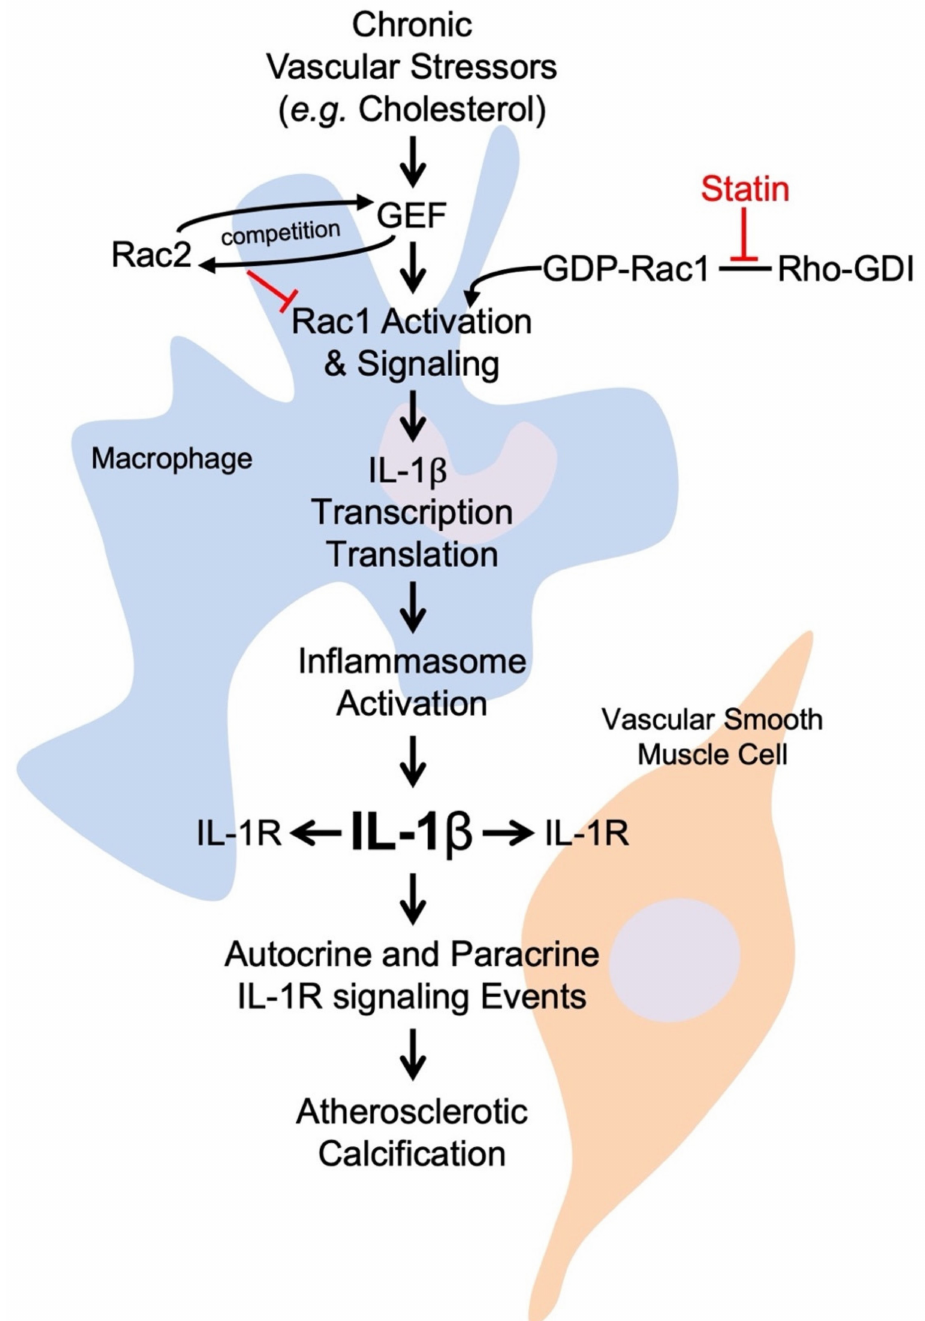
Figure 5. Working model of how Racs mediate IL-1 β expression and the consequent atherosclerotic calcification. Vascular stressors activate innate inflammatory pathways in macrophages, leading to Rac1 activity. Rac2 competes with Rac1 for common GEFs, tempering Rac1 activity for any given stimulus. Rac1 activity is associated with elevated IL-1 β expression, though the underlying mechanisms are not yet fully defined. Increased IL-1 β expression and the consequent IL-1 β –IL-1R signaling promotes atherosclerotic calcification by activating osteogenic gene programs in vascular smooth muscle cells. Statin treatment disrupts the complex between Rac1 and Rho-GDI while also allowing for increased Rac1 activation and Rac1-mediated IL-1 β